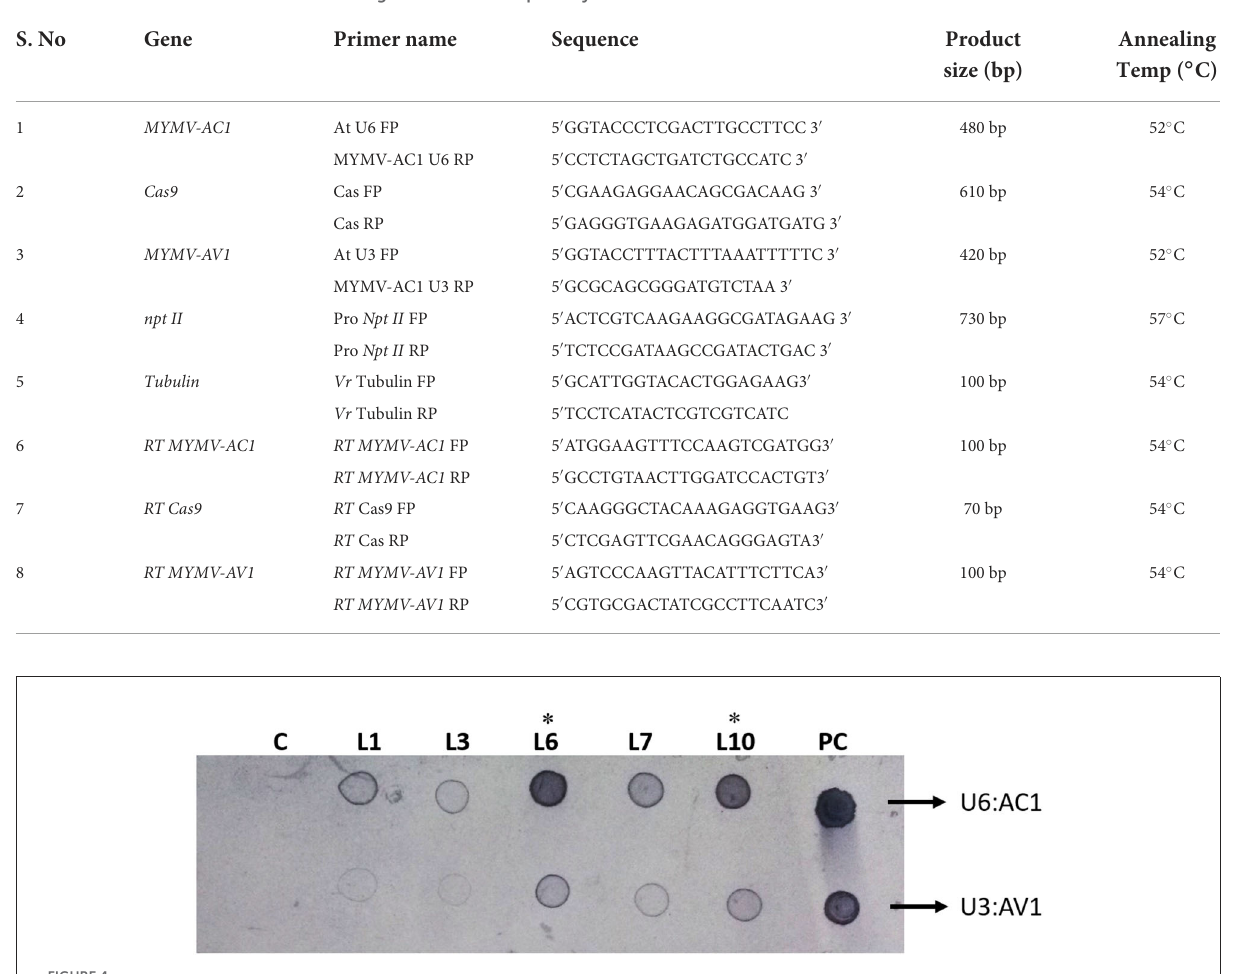
FIGURE4 Chromogenic visualization of transformed cassettes in greengram plants by dot blot: DNA (5 µ g) from the five PCR-positive T 0 plants was loaded on a nylon membrane and probed with U6:AC1 and U3:AV1 gene fragments. The blue color precipitation was observed in Lanes 1, 3, 4, 6, and 10. No band appeared in the control plant (C). *The blue color precipitation of both gRNA cassettes was very high in lanes 6 and 10. Hence plant 6 was used for Sequencing of all fragments and also advanced to the next